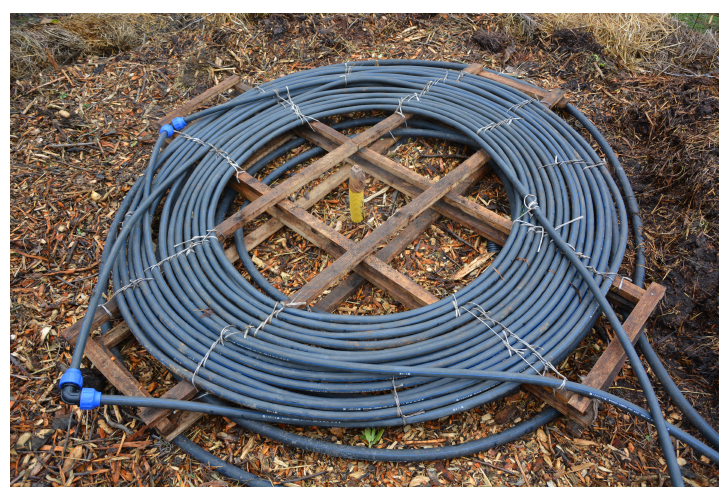
Figure 4. Prototype of the heat exchanger: L-shaped fittings connect three shorter sections of the pipe forming a total length of 61.2 m. Wider LDPE pipe visible underneath the exchanger is a potential second heat exchange loop—it had not been used in this experiment.